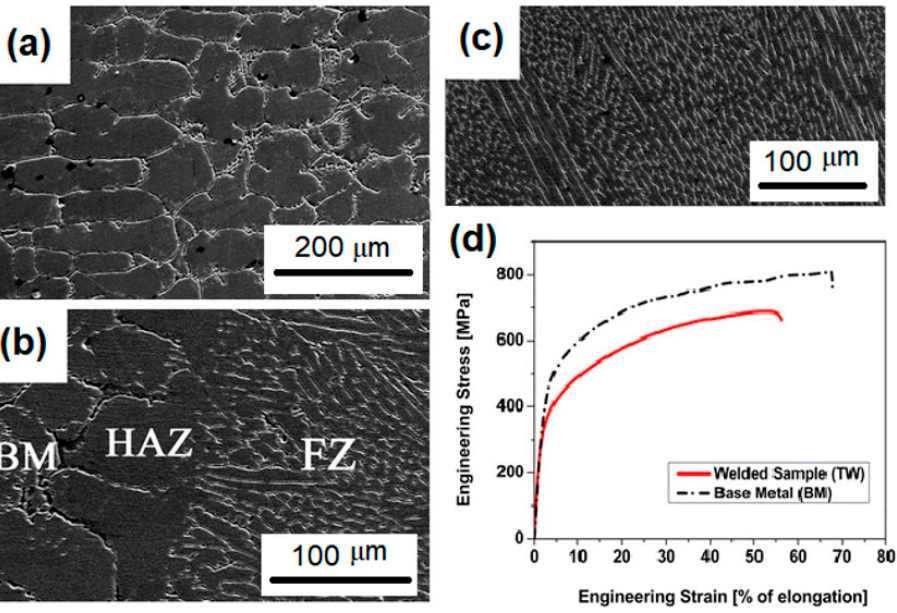
Figure 1. Gas-tungsten arc (GTAW) technique to weld an Al 0.5 CoCrFeNi alloy ( a ) base metal zone microstructure, ( b ) BM + HAZ + FZ region, ( c ) FZ microstructure, and ( d ) comparison of the mechanical (BM) microstructure, ( b ) BM+HAZ+FZ region, ( c ) FZ microstructure, and ( d ) comparison of the strength of the BM and welded sample. Adapted from mechanical strength of the BM and welded sample. Adapted from [23].